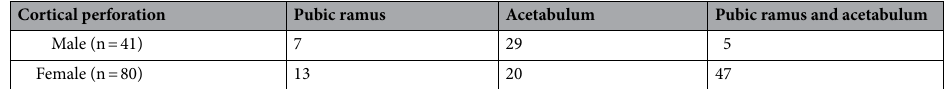
Cortical perforation Pubic